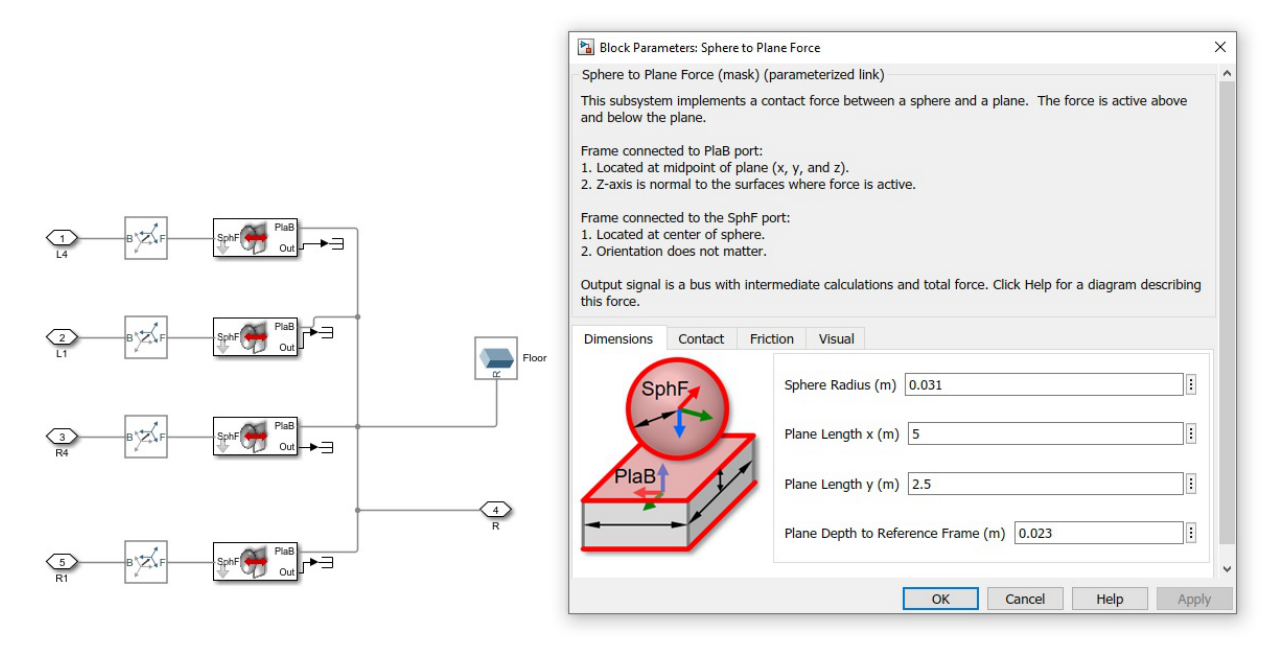
Figure 5. Simscape block parameters for sphere-to-plane contact.